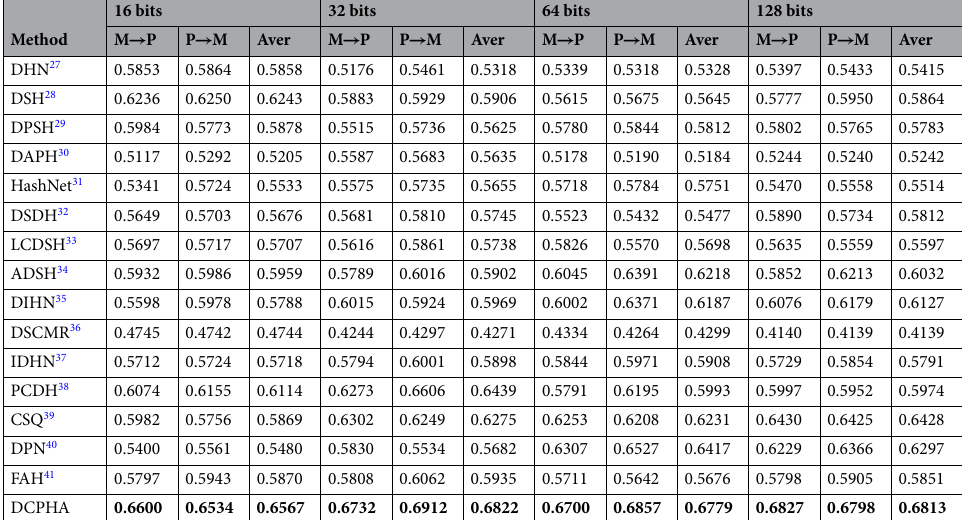
Table 2. The mAP scores of cross-modal retrieval on ADNI2 with different lengths of hash codes. Best Performance in Bold.